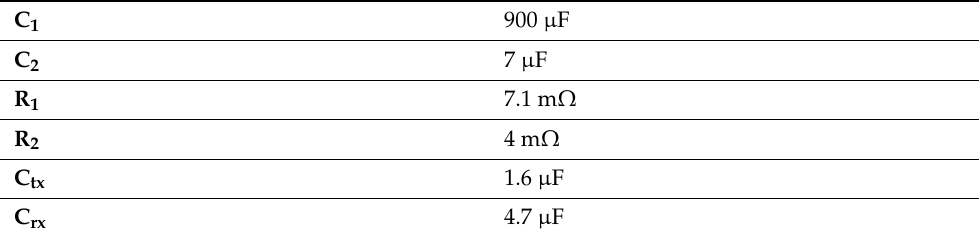
Figure 7. System efficiency and frequency from ANSYS Simplorer. Table 2. The circuit components values.